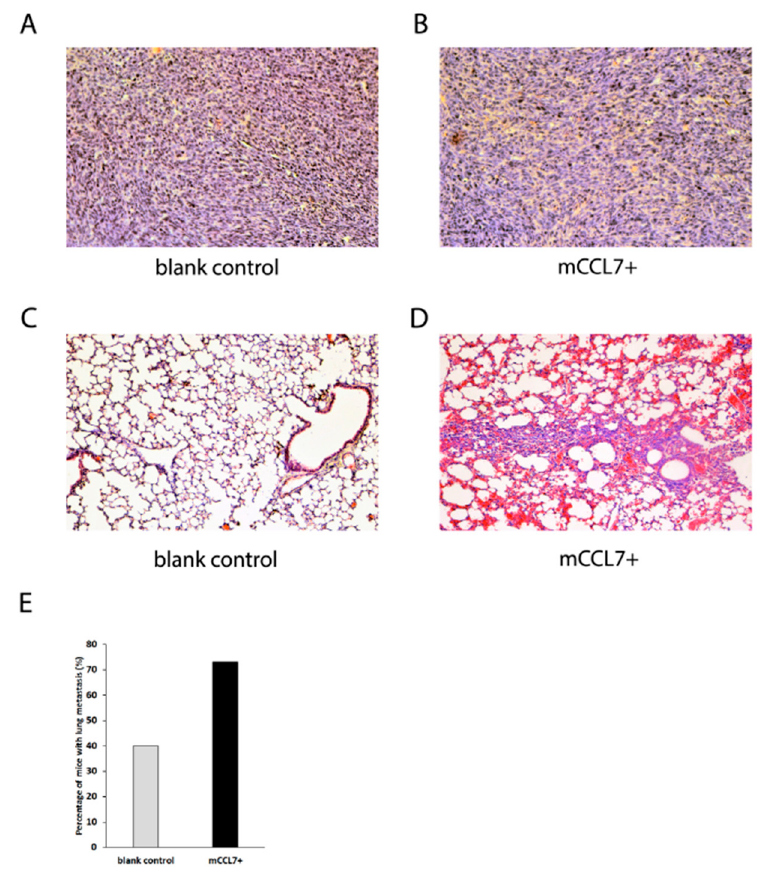
Figure 3. CCL7 affects lung morphology and metastasis in vivo : ( A ) tumors stained for hematoxylin and eosin (blank control); ( B ) tumors stained for hematoxylin and eosin (mCCL7+); ( C ) lungs stained for hematoxylin and eosin (blank control); ( D ) lungs stained for hematoxylin and eosin (mCCL7+); and ( E ) percentage of tumor-bearing mice developing lung metastasis ( n = 6–8 mice per group, 8 sections per mouse).